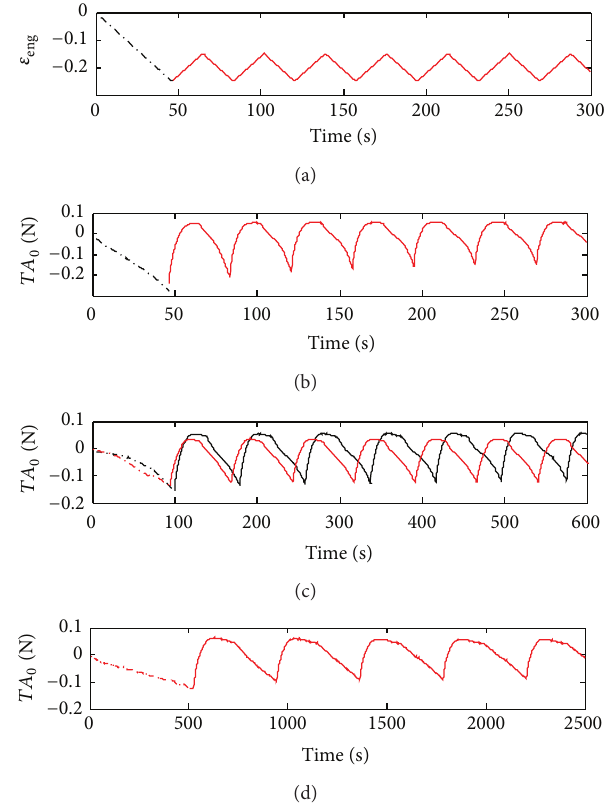
Figure5: Identificationdata(sample1)andvalidationdata(samples 2, 3, and 4). (a) and (b) correspond to engineering strain ( 𝜀 )/𝑒 𝑇𝐴 (𝑒 − 𝑒 0 0 ) and load ( 0 ) of sample 1, respectively. (c) correspond to 𝑇𝐴 0 of sample 2 (red) and 3 (black). In (d) is shown sample 4. The dashed-dotted lines indicate the first compression of each sample (Neo Hookean